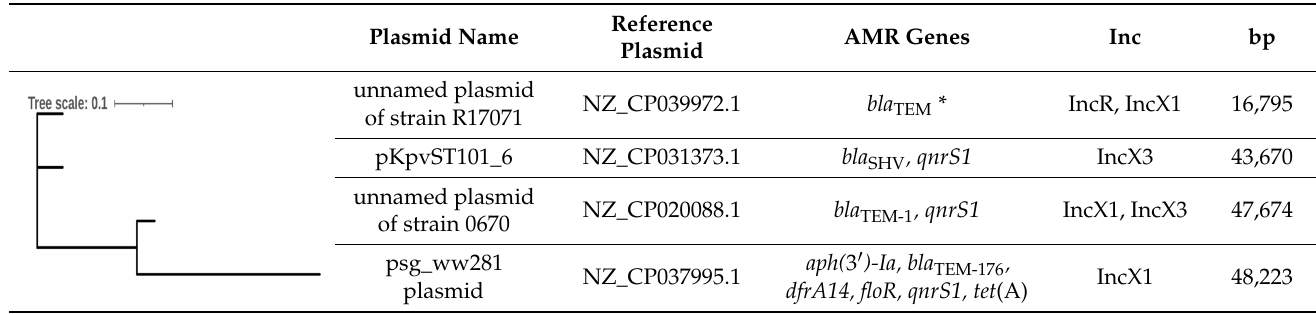
Table 2. Characteristics of best-matching IncX plasmids carrying qnrS 1 with aligned neighbour-joining tree without distance corrections of all four best matching reference plasmids based on Clustal Omega multiple sequence alignment.